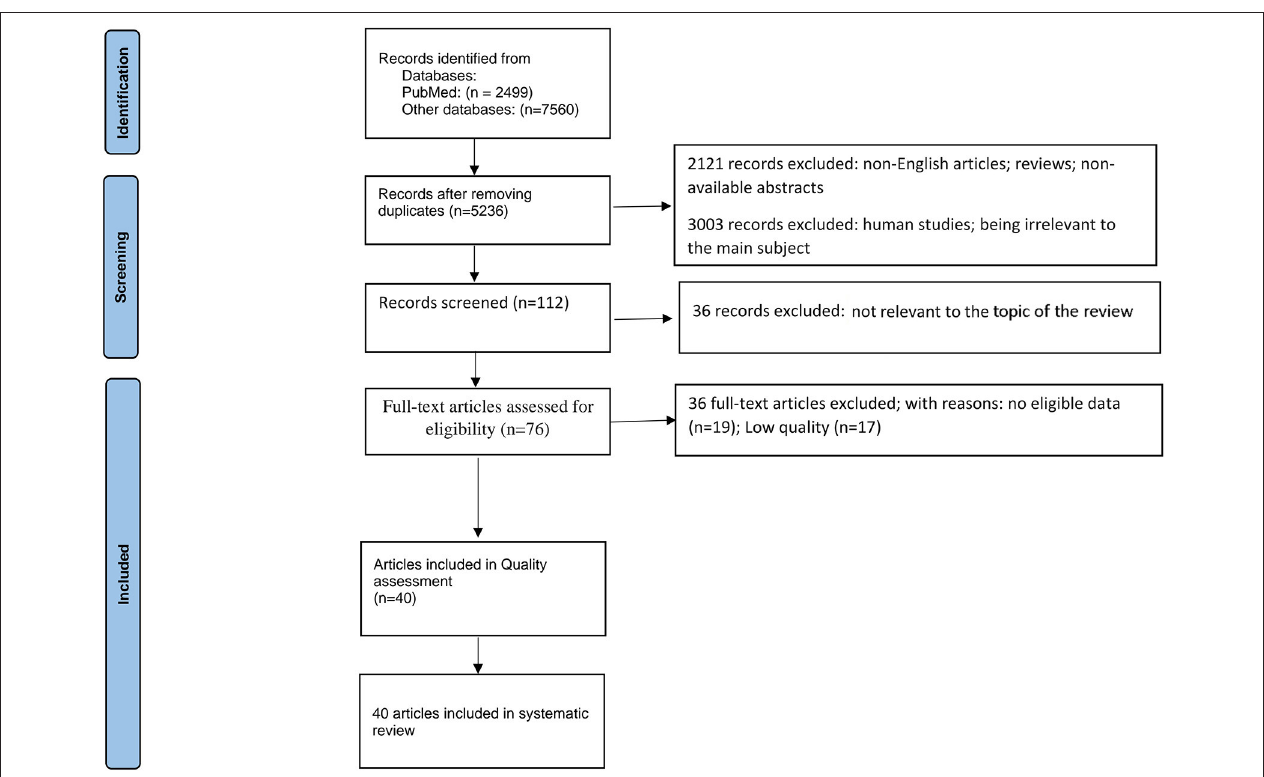
FIGURE 1 | PRISMA 2020 flow diagram for systematic reviews which included searches of